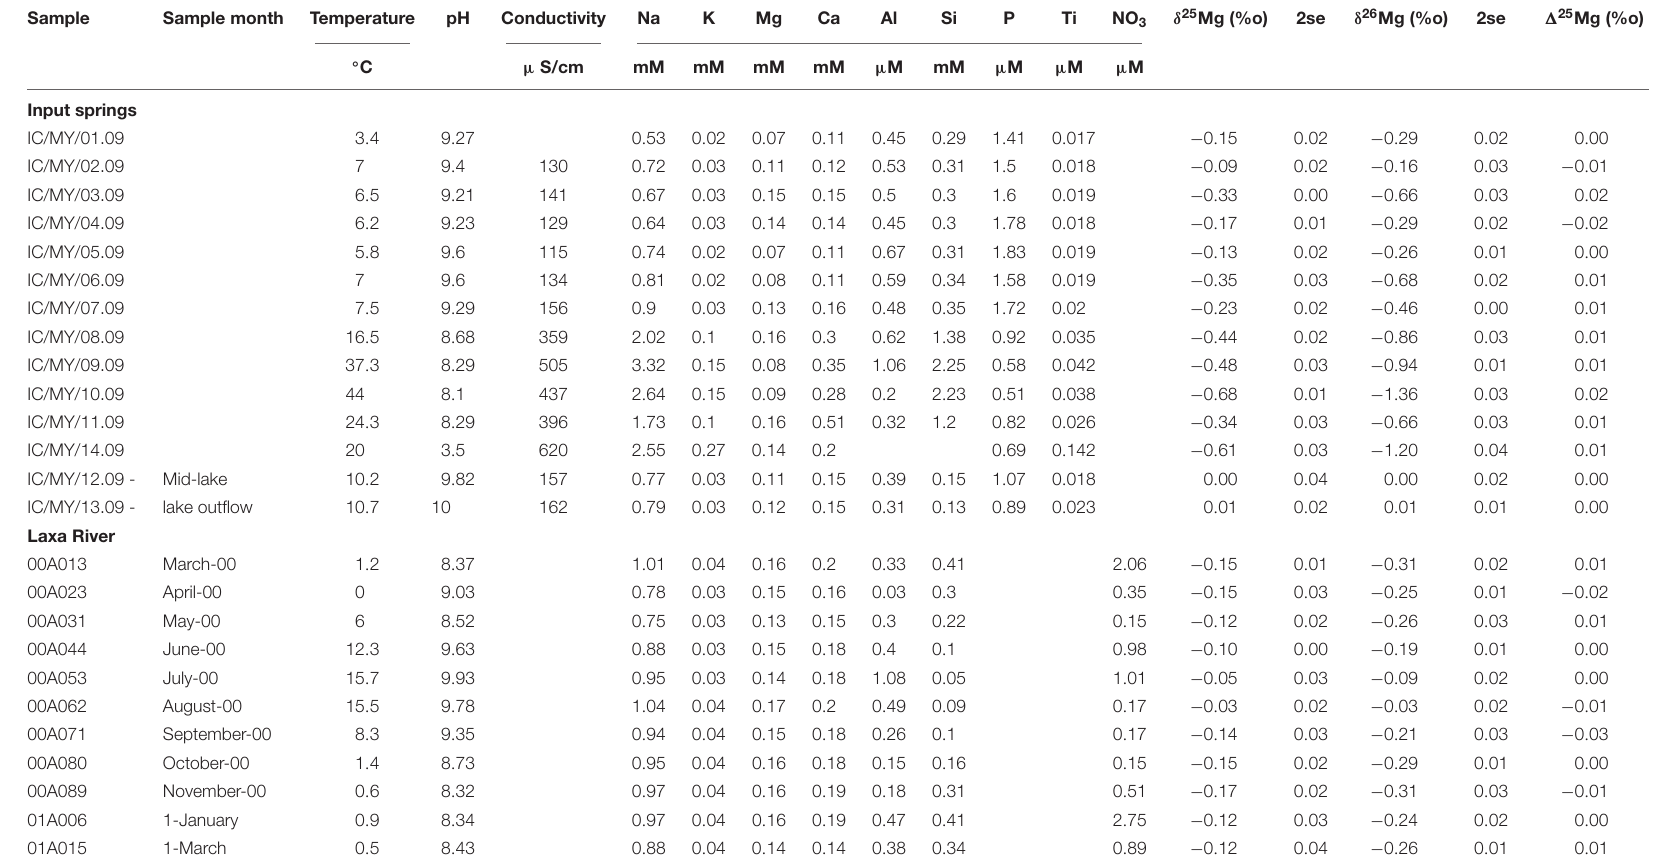
TABLE 1 | Concentration and isotope data for the Lake Myvatn